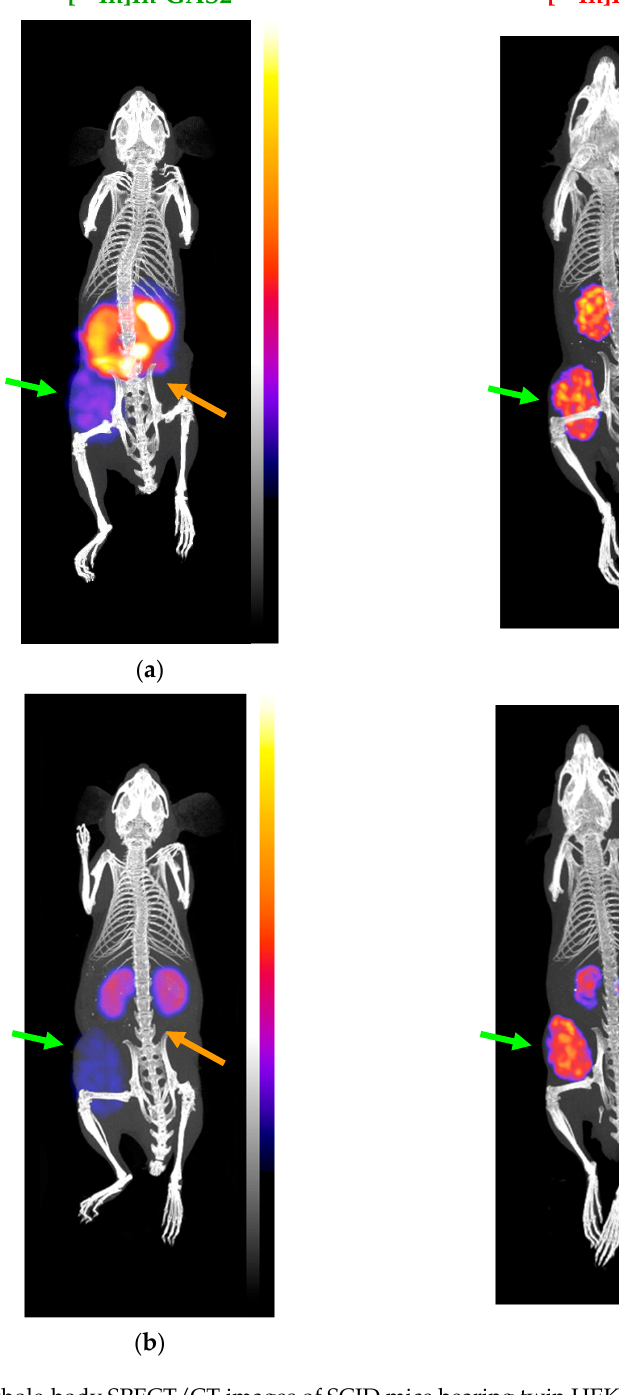
Figure 5. Static whole-body SPECT/CT images of SCID mice bearing twin HEK293-CCK 2i4sv R and wtHEK293 tumors in their flanks at ( a ) at 4 h pi and ( b ) at 24 h pi of [ 111 In]In-GAS1/2/3; green arrows are pointing to HEK293-CCK 2i4sv R xenografts, and orange arrows are indicating the wtHEK293 tumors. Intense uptake is observed in the CCK 2i4sv R expressing tumors, but no uptake is evident in the tumors devoid of CCK 2i4sv R expression. The color bars indicate the difference in accumulated activity (purple being the lowest and white being the highest level of accumulation).